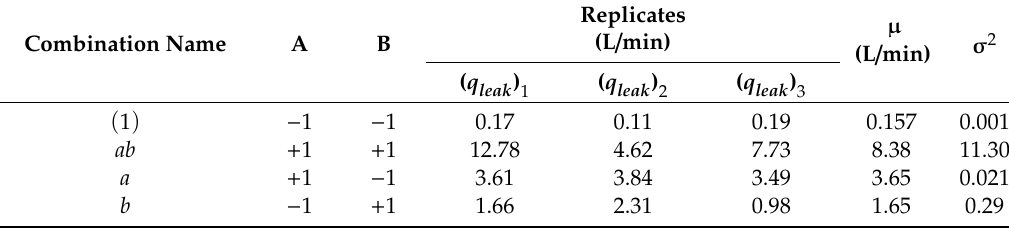
Figure 6. EAC with PVA support. Table 3. Plan 2 2 with three replicates.